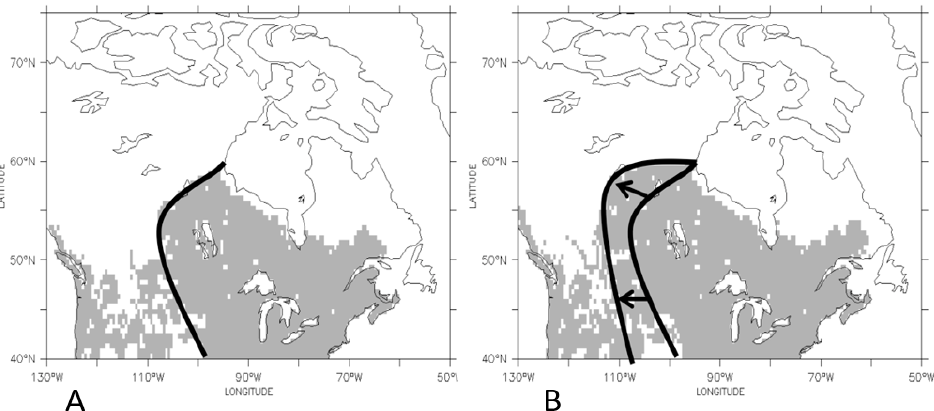
Figure 7. Map of the extent that deciduous forest migrated with directed dispersal at ( A ) 1 km a year with the standard disturbance rate, and ( B ) double the disturbance rate.